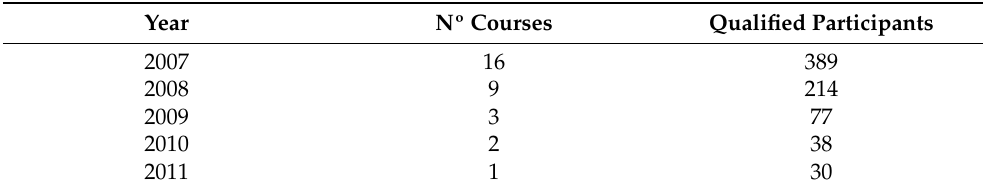
Table 1. IFAPA IPM courses held in the La Mojonera installations (Almer í a).